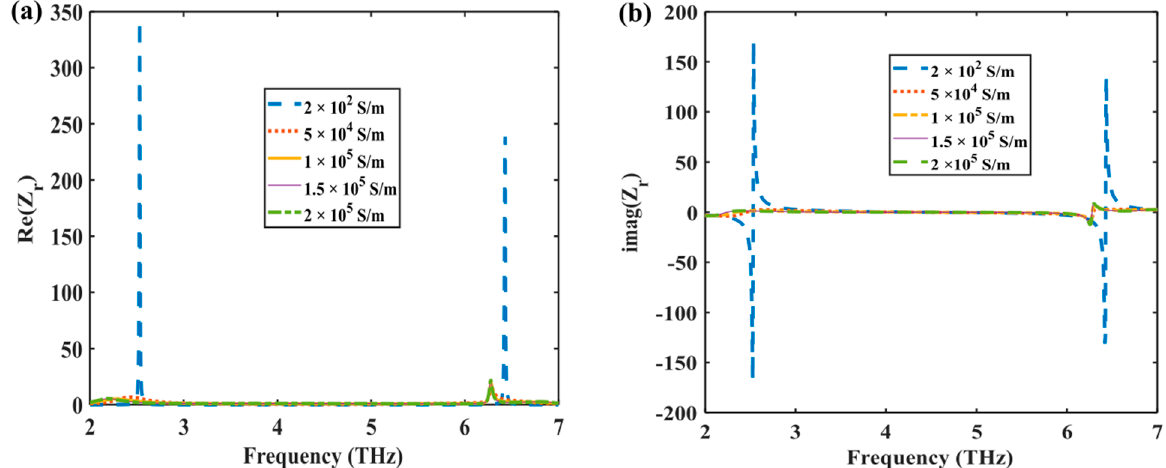
Figure 8. Simulation results ( a) real part and ( b ) imaginary part of the relative impedance for VO 2 with various conductivities.